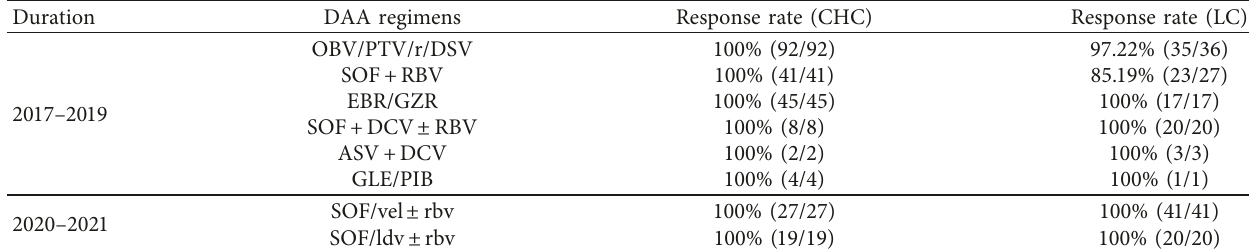
DAA, directing antiviral agents; CHC, chronic hepatitis C; LC, liver cirrhosis; OBV/PTV/r, ombitasvir/paritaprevir/ritonavir; DSV, dasabuvir; SOF, sofosbuvir; RBV, ribavirin; EBR/GZR, elbasvir/grazoprevir; DCV, daclatasvir; ASV, asunaprevir; GLE/PIB: glecaprevir/pibrentasvir; VEL, velpatasvir; LDV,